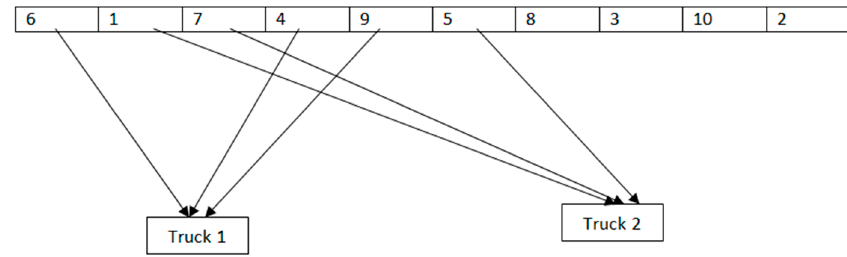
Figure 10. Simpli fi ed interpretation of the output.